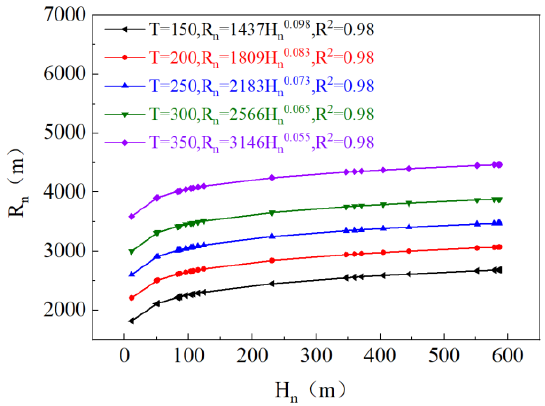
Figure 8. R n regression results.